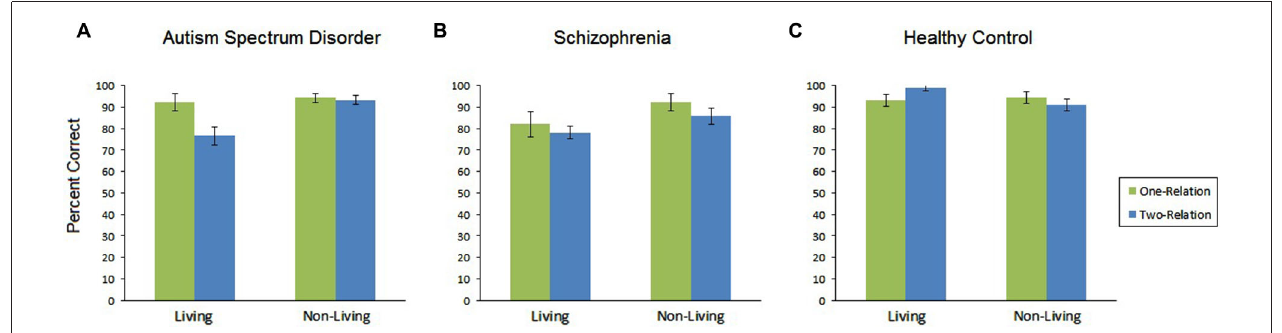
solving two-relation, non-living problems. (B) SZ showed reductions in performance for non-living problems and a marginal reduction in performance on two-relation problems. (C) HC participants showed high performance across all problems